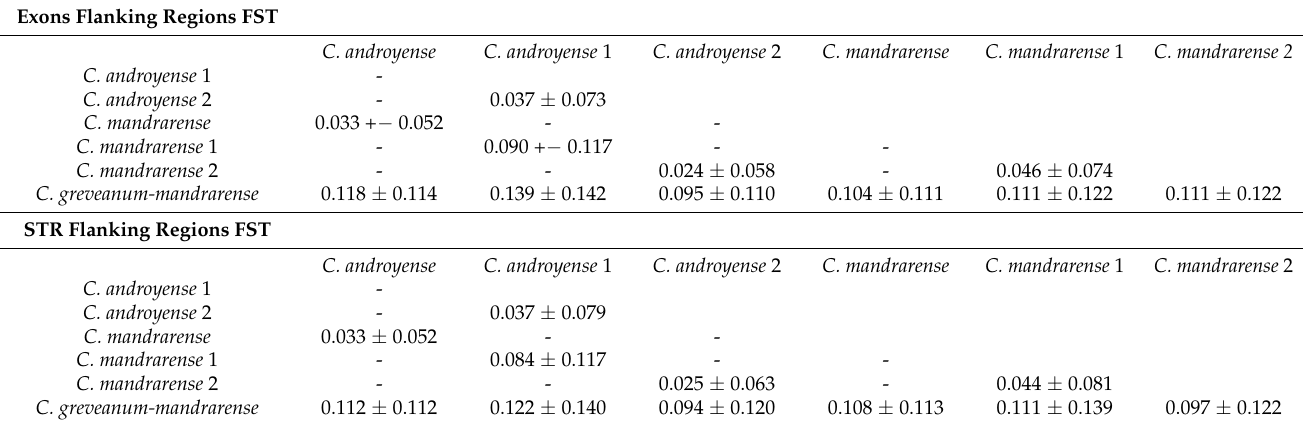
Table 5. FST values (weighted mean and standard deviation) within the Arid complex for the Capurodendron groups shown in Figure 5. The groups that were not compared are indicated with the symbol -.